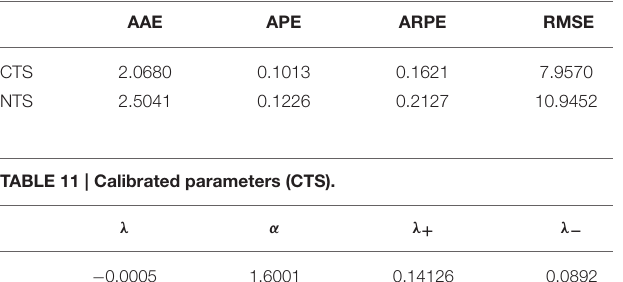
TABLE 10 | Errors of minimal entropy measure.